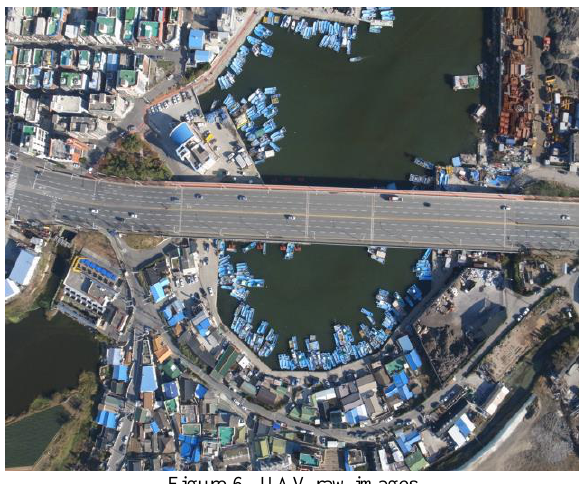
Figure 6. UAV raw